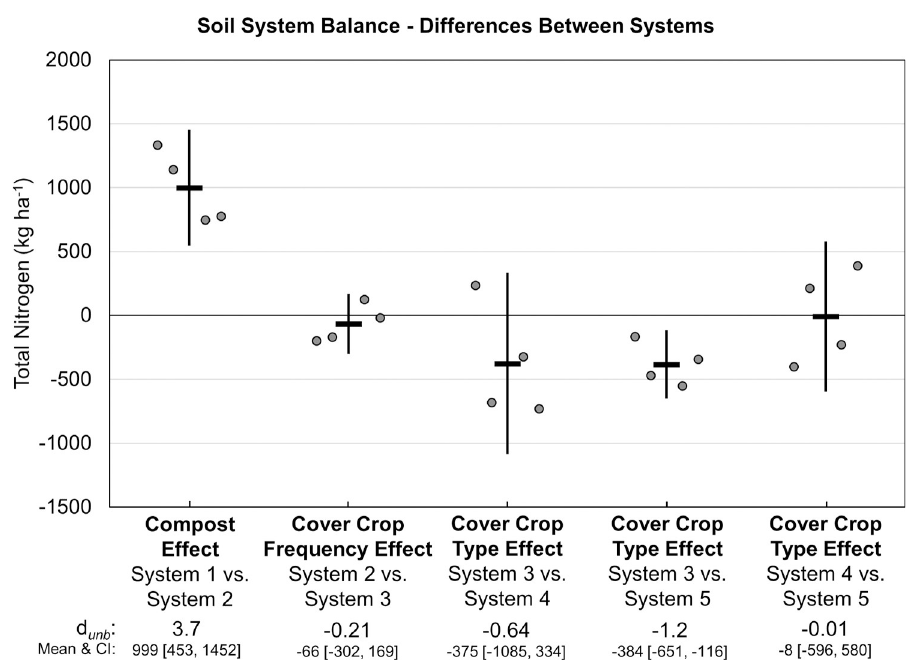
Fig 16. Mean paired difference in cumulative soil system nitrogen balance between systems over eight years of vegetable production. Measurements were taken in five organic vegetable systems. Systems differed by annual compost additions, cover crop type and cover cropping frequency. System 1 = no compost+legume-rye 4 th year; System 2 = annual compost+legume-rye 4 th year; System 3 = annual compost+legume-rye annually; System 4 = annual compost+mustard annually; System 5 = annual compost+rye annually. Error bars are 95% confidence intervals (CI) around the mean (horizontal line). Data points are replicates 1 through 4 averaged across years and are clustered around the mean left to right so as not to obscure the mean and CI. The standardized effect size (Cohen’s unbiased d , d unb ) is shown below the